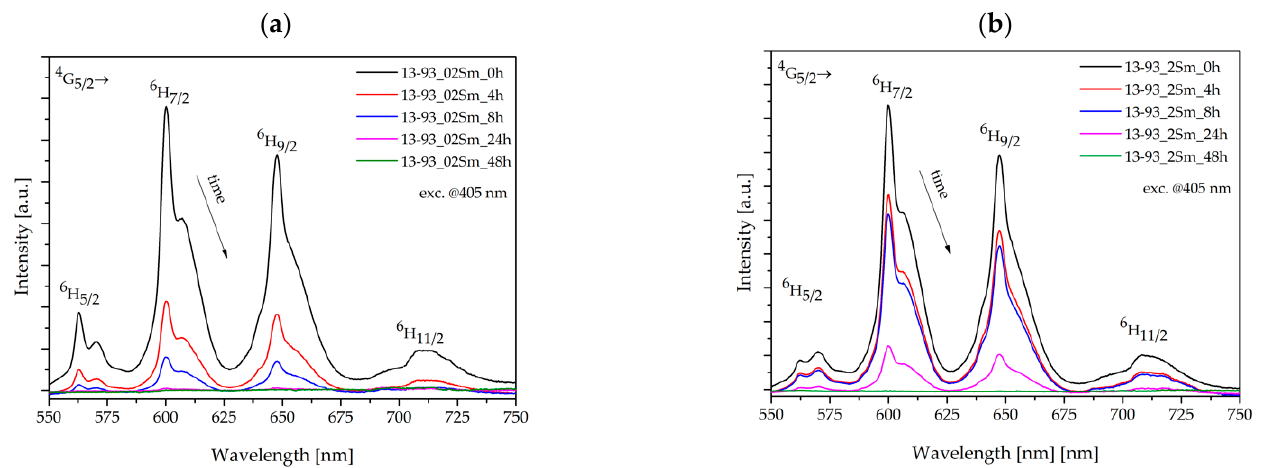
Figure 5. Emission spectra for ( a ) 13-93_02Sm and ( b ) 13-93_2Sm bioactive glass fibers immersed in simulated body fluid (SBF) for 0, 4, 8, 24, and 48 h.